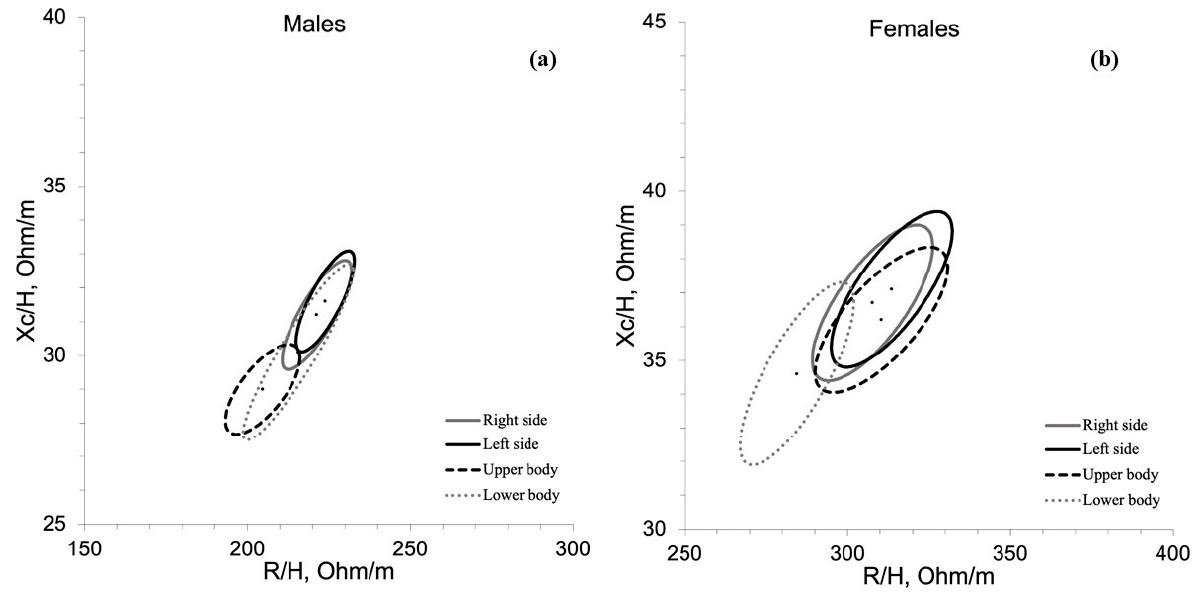
Figure 3. Bioelectrical characteristics of the sample for both sexes, for right and left sides and upper and lower body. Caption: ( a ) BIVA vectors of the right and left sides and on the upper and lower body in males. ( b ) BIVA vectors of the right and left sides and on the upper and lower body in